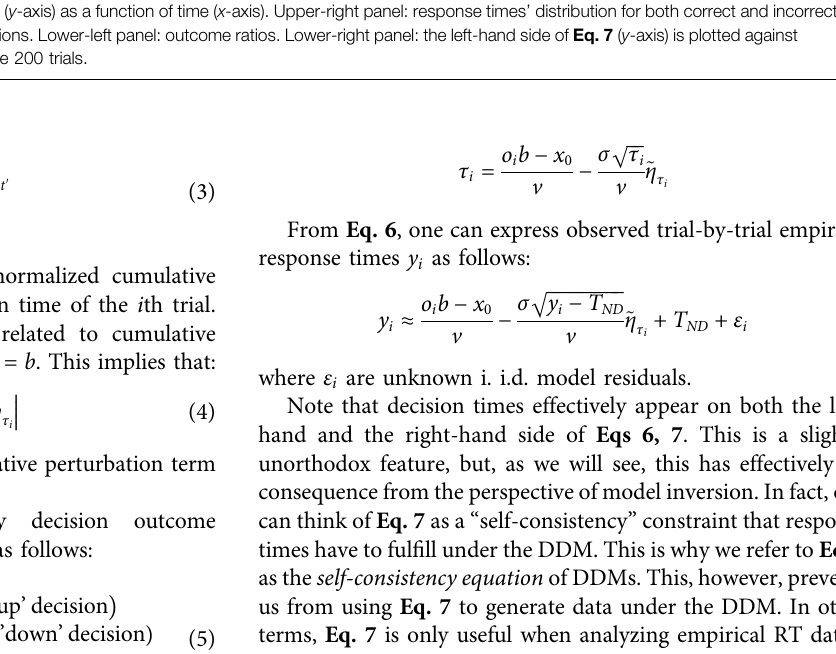
Figure 5 below exempli fi es the accuracy of DDM ’ s self- consistency equation, using a Monte-Carlo simulation of 200 trials under the vanilla DDM.